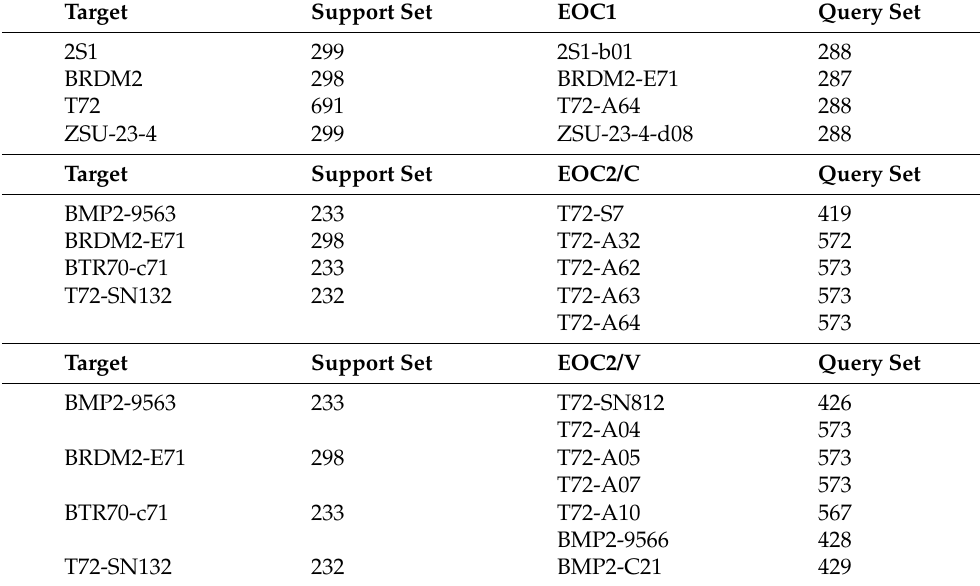
Table 2. Categories among MSTAR